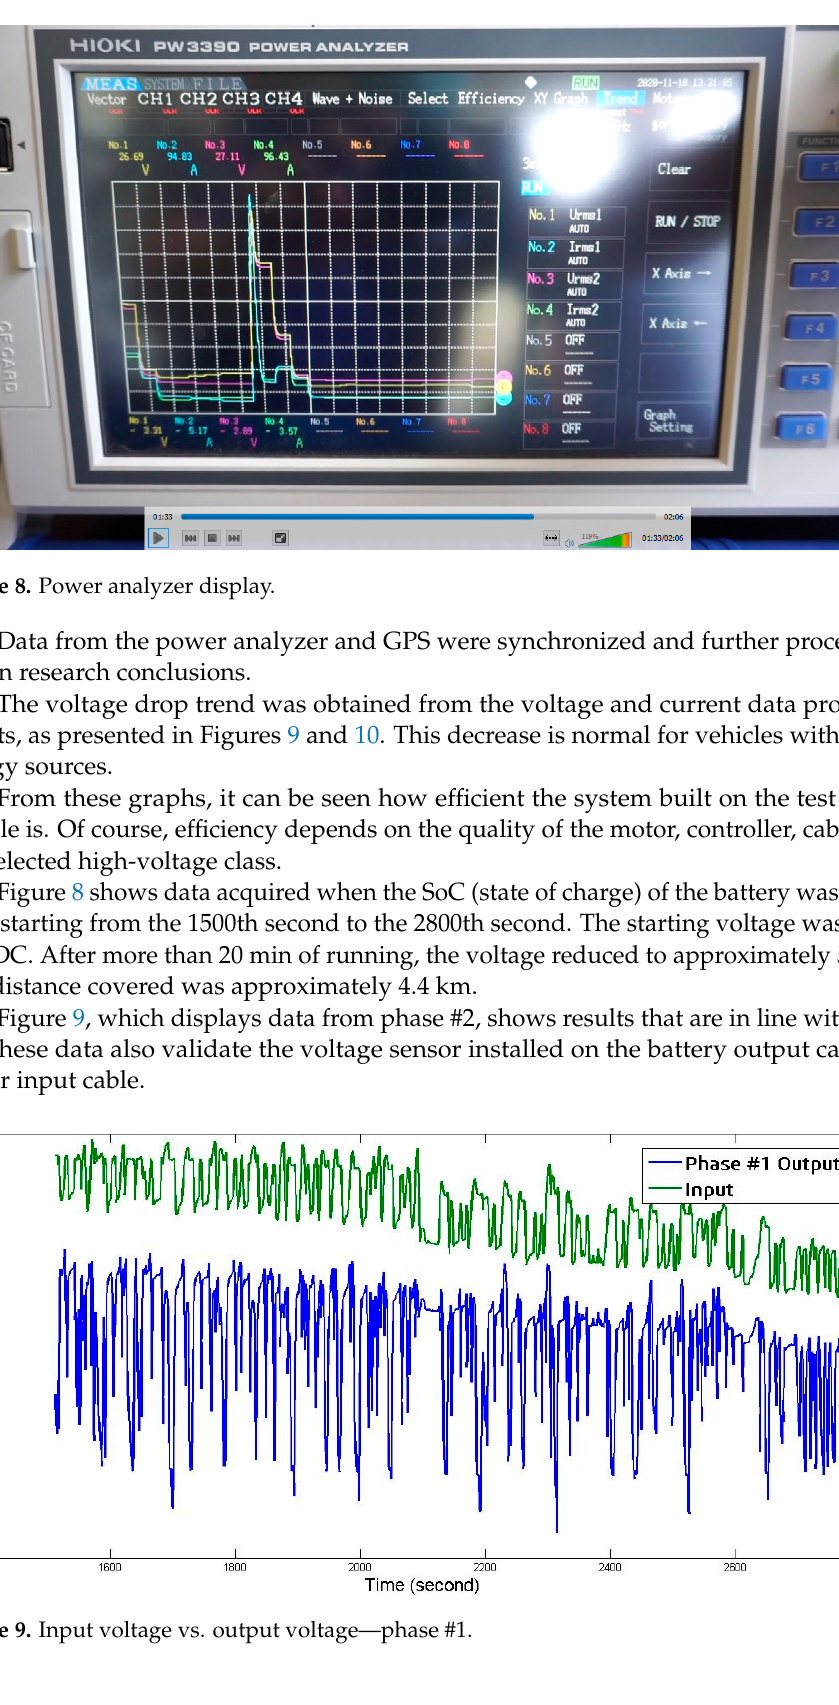
Figure 9. Input voltage vs. output voltage—phase #1.